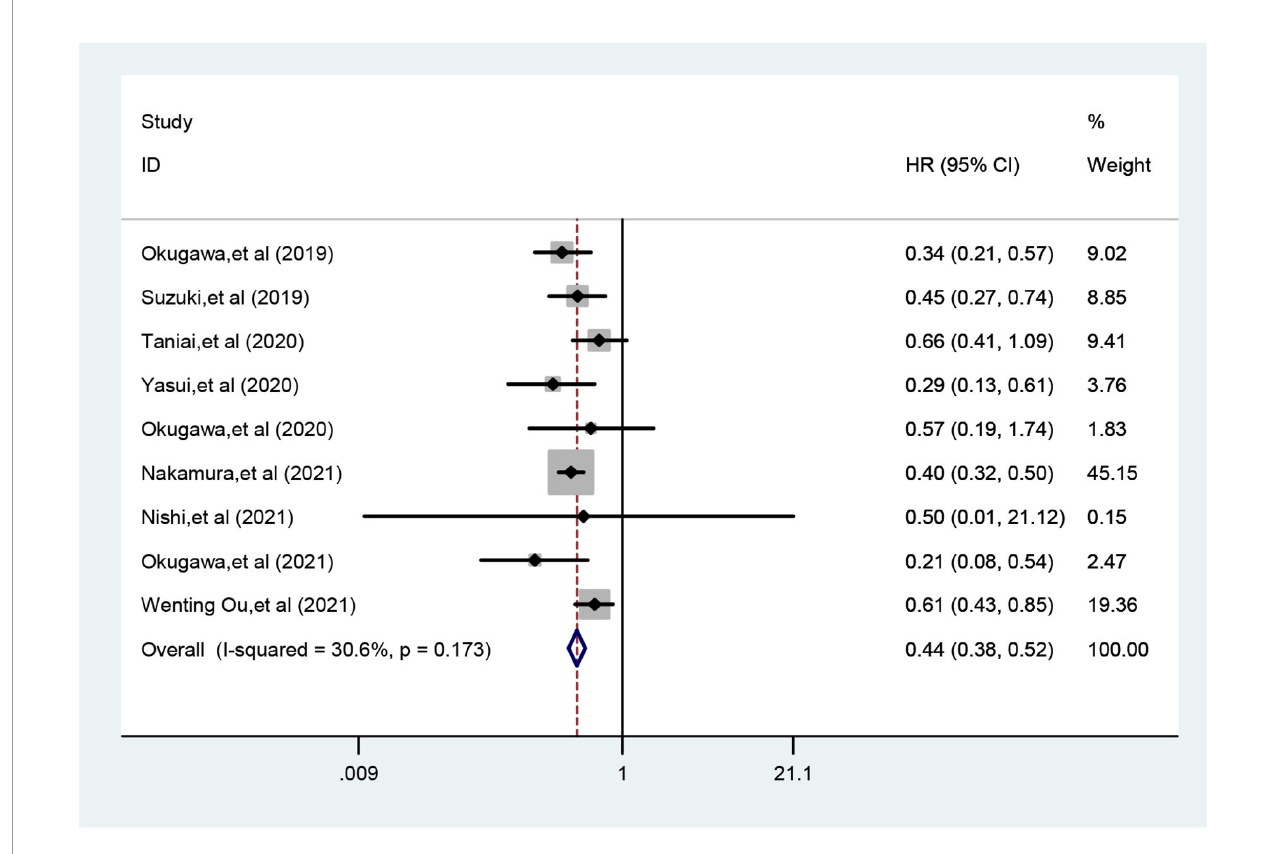
FIGURE 2 | Meta-analysis of relationship between LCR and